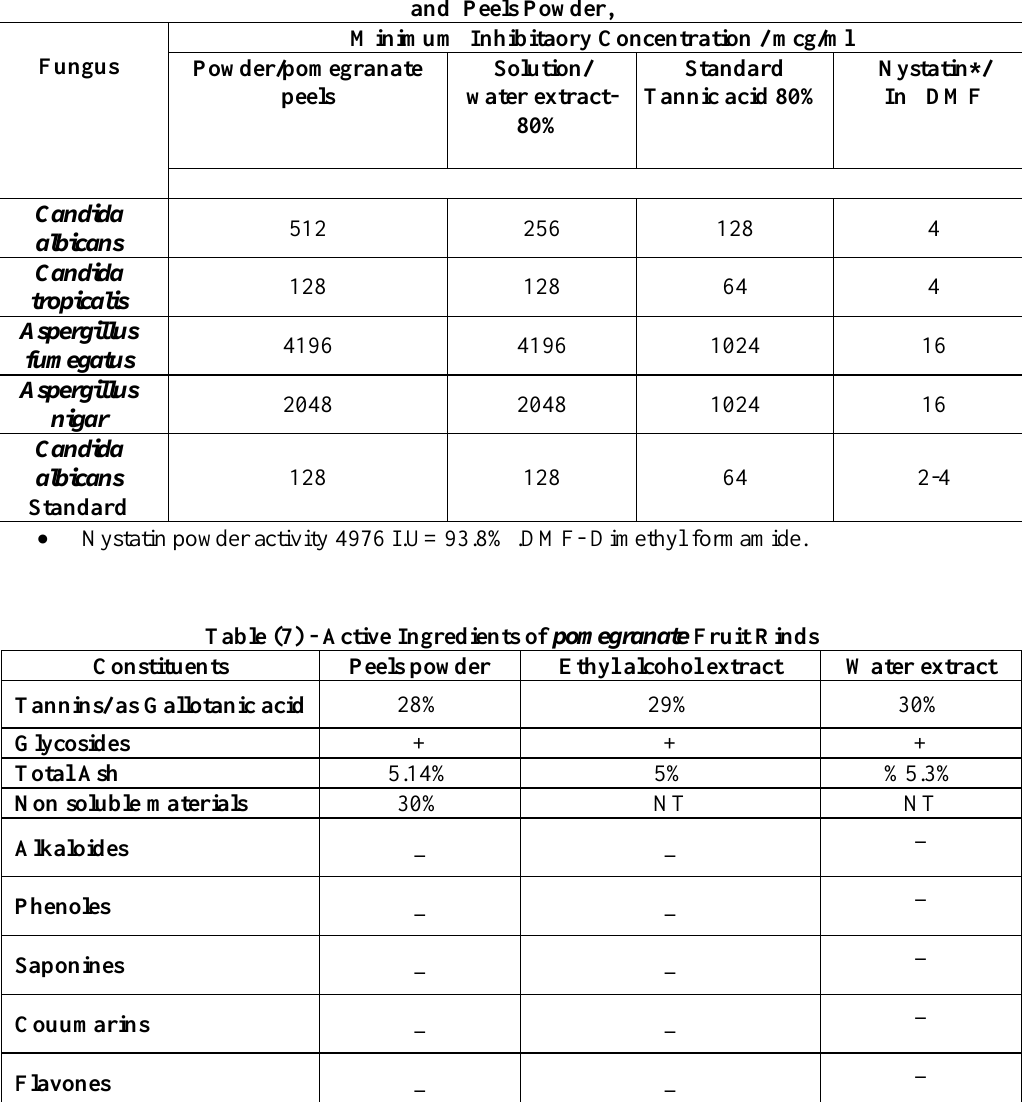
Table (6) - Minimum Inhibitory Concentrations µg/ml of Punica granatum (Pomegranate) Peels